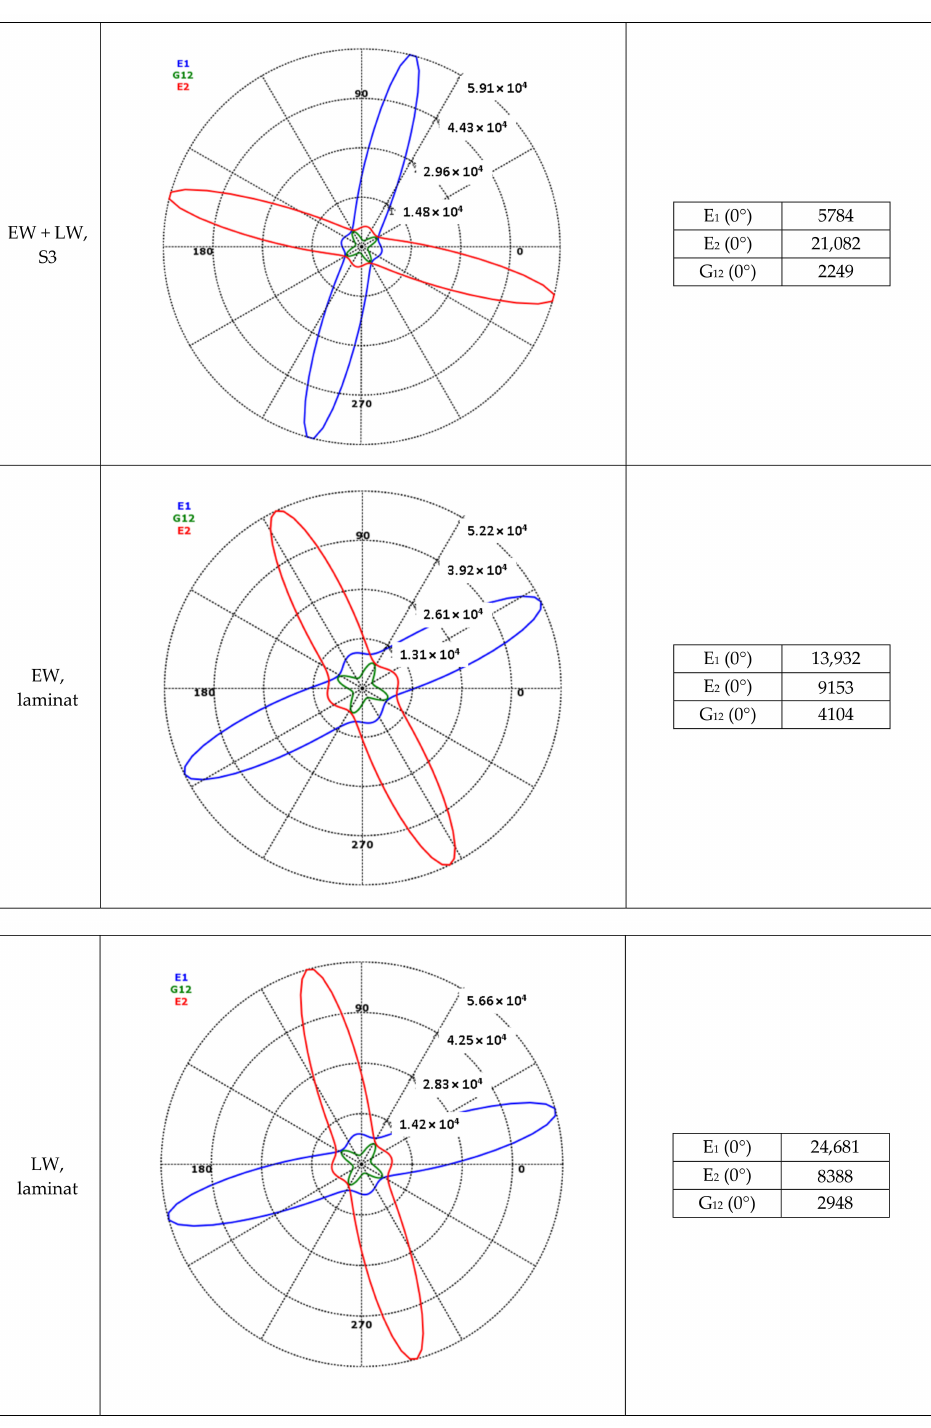
Figure 5. Calculated mechanical properties of cell wall layers of